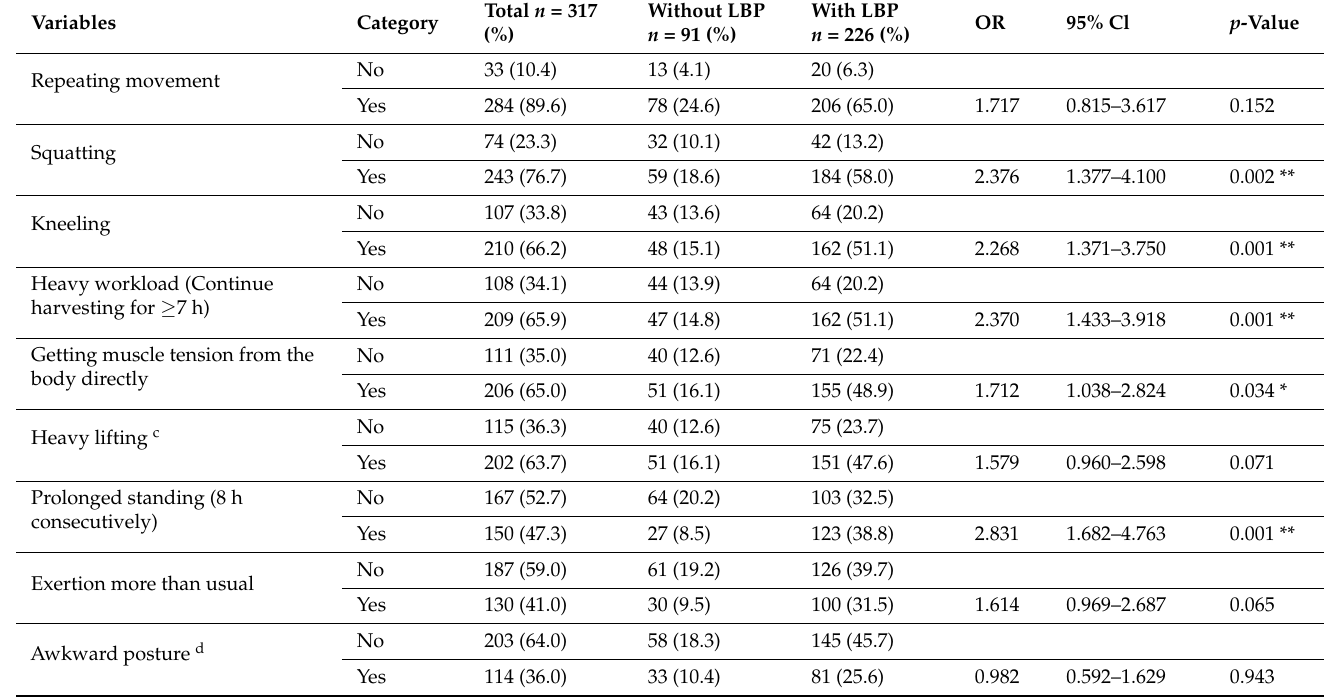
Table 3. Ergonomics risk factor of LBP predictors among rubber farmers ( n =